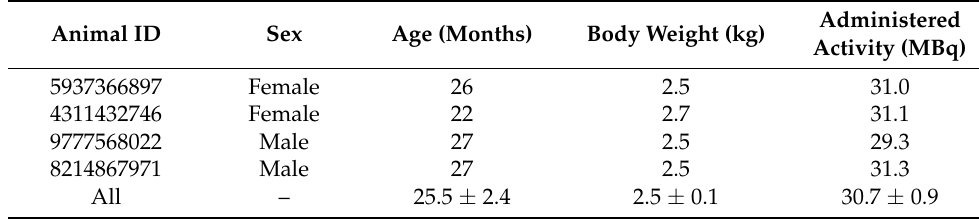
Table 1. Characteristics of the experimental monkeys, and the injected 64 Cu-NCAB001 doses.